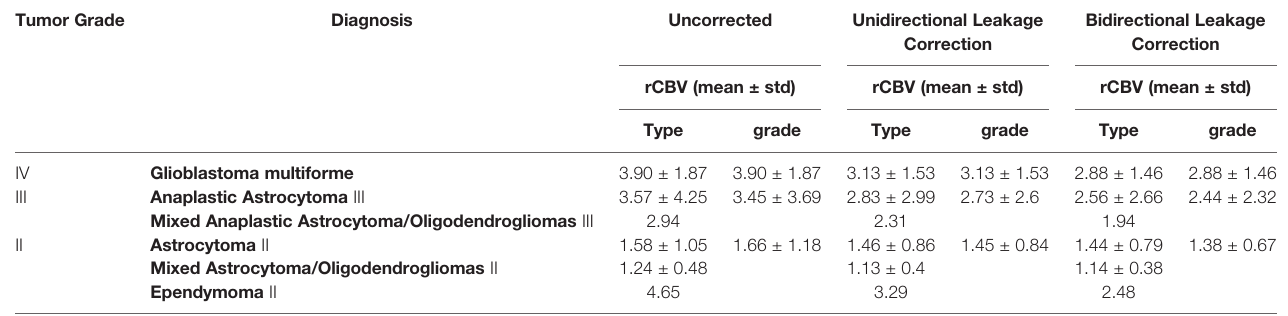
TABLE 3 | Patient averages of uncorrected and corrected rCBV for the different tumor types and the grades in TCIA. Tumor